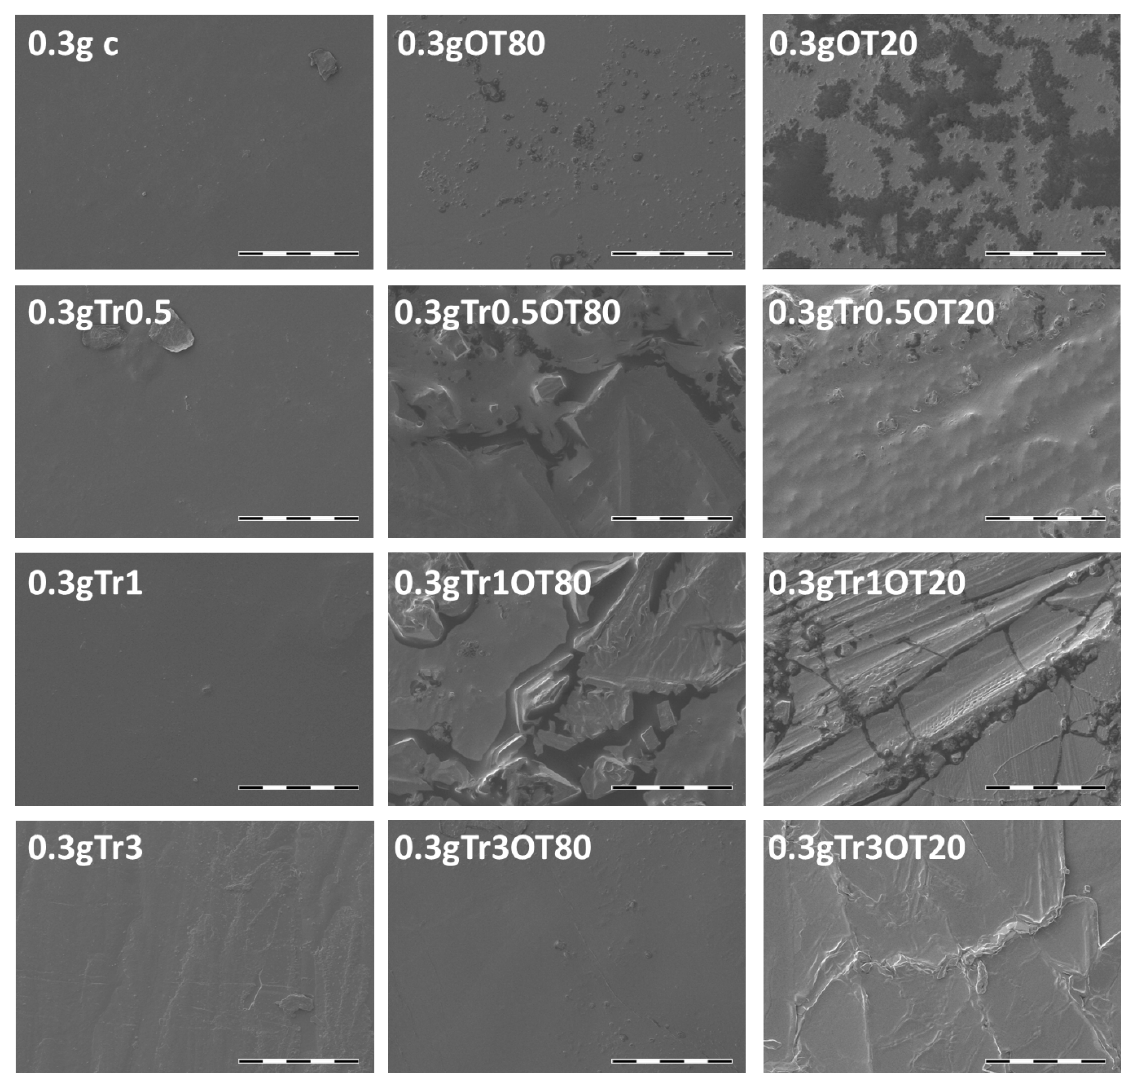
Figure 5. The SEM micrographs of films that consisted of 0.3 g of κ -carrageenan (voltage = 5 kV, current = 60 pA, scale bar = 100 µm).